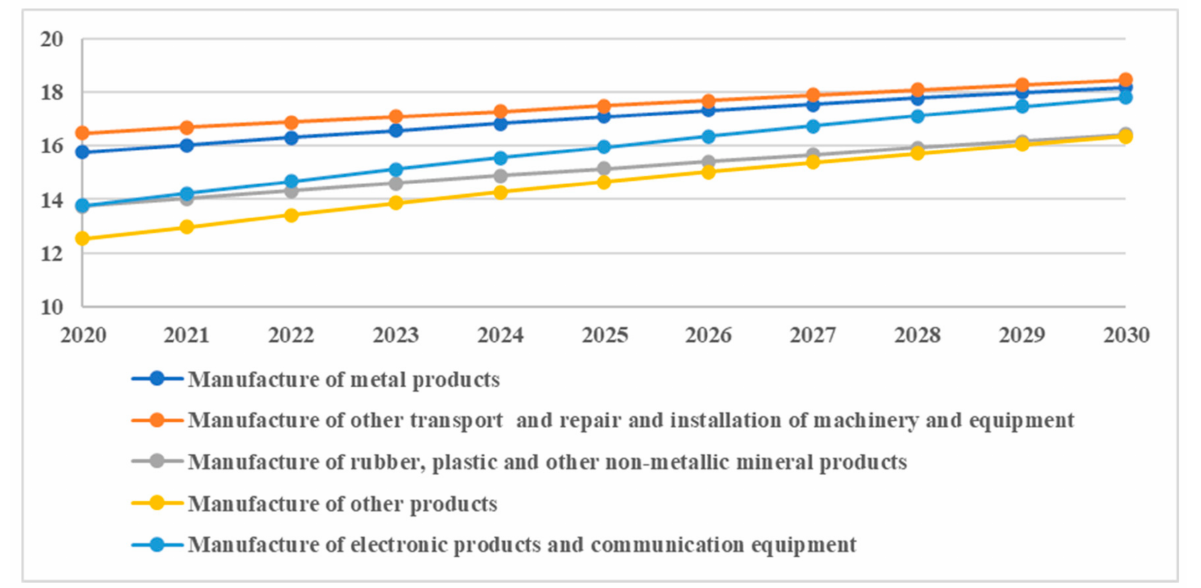
Figure 16. Real wages (and salaries) till 2030, EUR/h (own